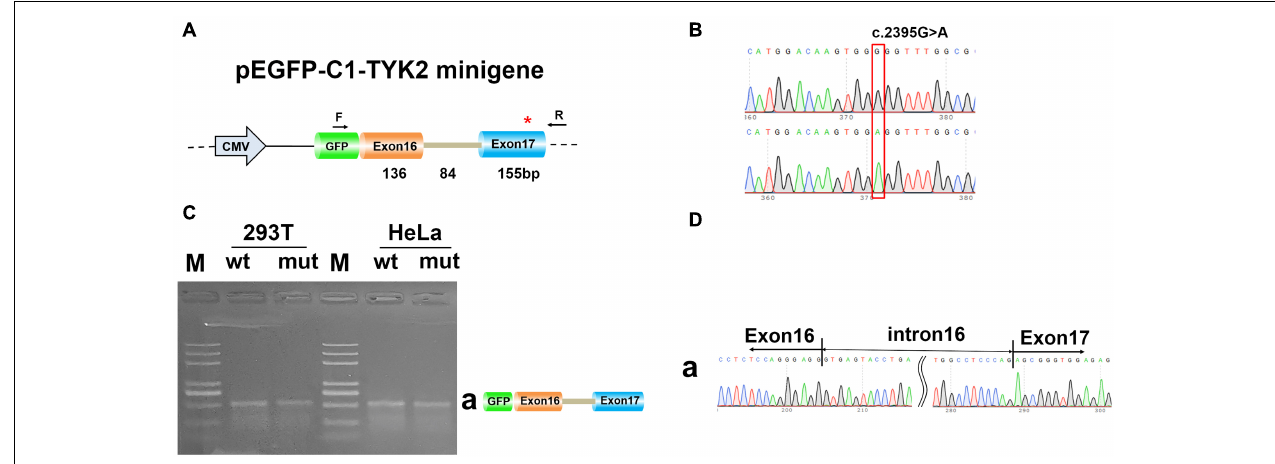
FIGURE 3 | Minigene analysis based on pEGFP-C1-TYK2-wt/mut recombinant vector. (A) Schematic illustration of cloned vectors. (B) Sanger sequencing results of the recombinant vector. (C) Electrophoresis results of transcript PCR products in both 293T and HeLa cell lines. (D) Sanger sequencing of PCR products. Red * indicates the mutation site.